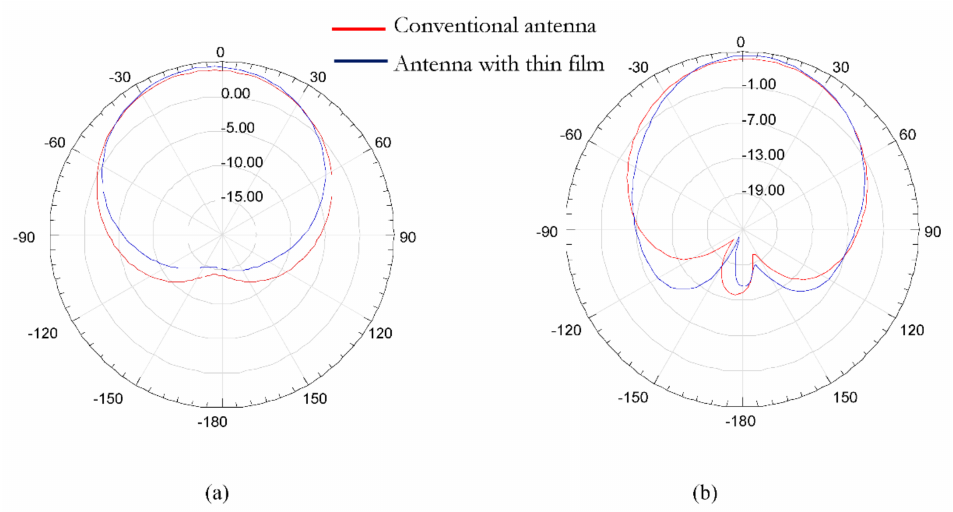
Figure 10. Microstrip patch antenna radiation patterns with and without a thin-film material at 4 GHz; ( a ) E plan, ( b ) H plan.